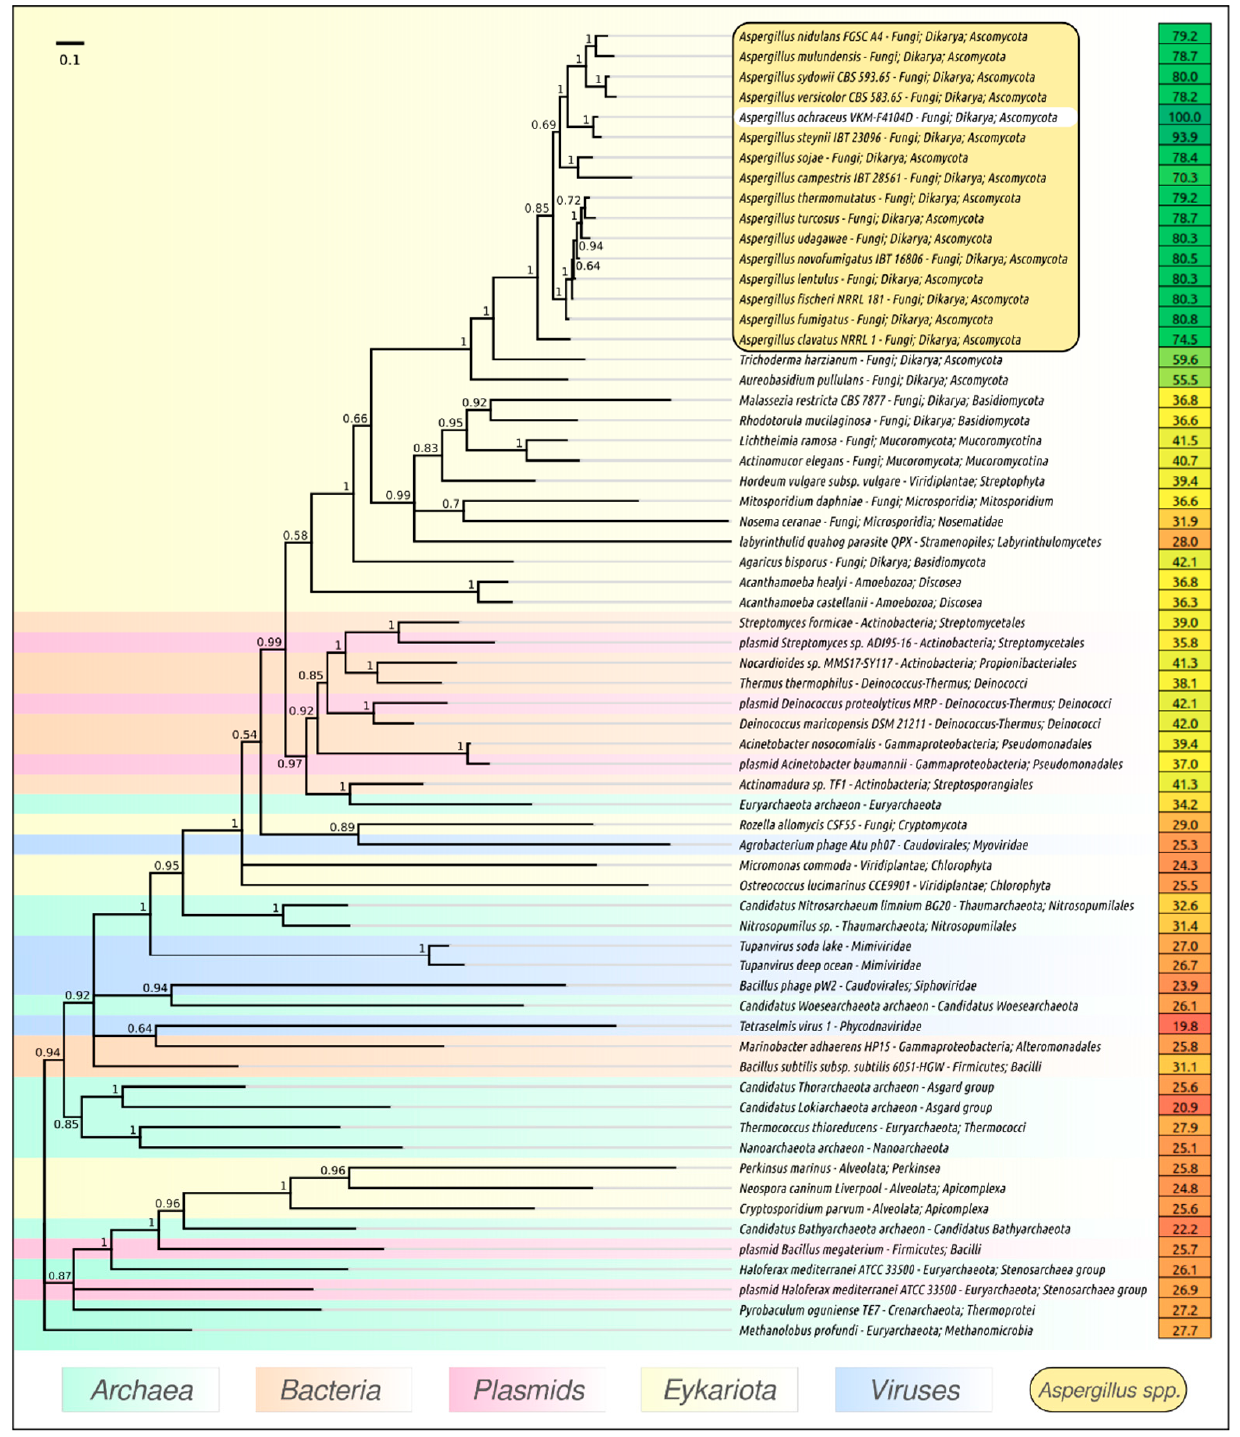
Figure 3. Phylogenetic tree obtained with MrBayes based on alkaline protease protein sequences found with a BLAST search of NCBI databases. Bayesian posterior probabilities are indicated above their branch. Taxonomic classification is taken from NCBI sequence attributes and is shown to the right of the organism name. The percentage of amino acid identity compared to Aspergillus ochraceus VKM-F4104D alkaline protease is shown in the right column. The scale bar shows 0.1 estimated substitutions per site and the tree was rooted to Methanolobus profundi ; of 2,000,000 generations, every 200 generations were sampled, with an average standard deviation of split frequencies of 0.0091.